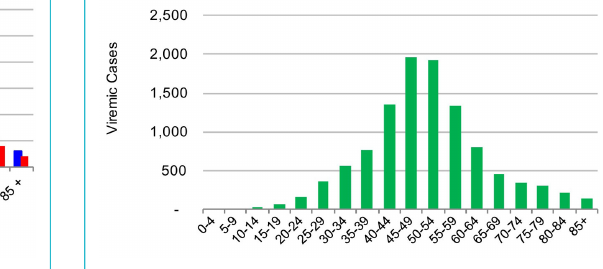
Figure 6: Distribution of hepatitis C cases by five year age cohort in the canton of Zurich in